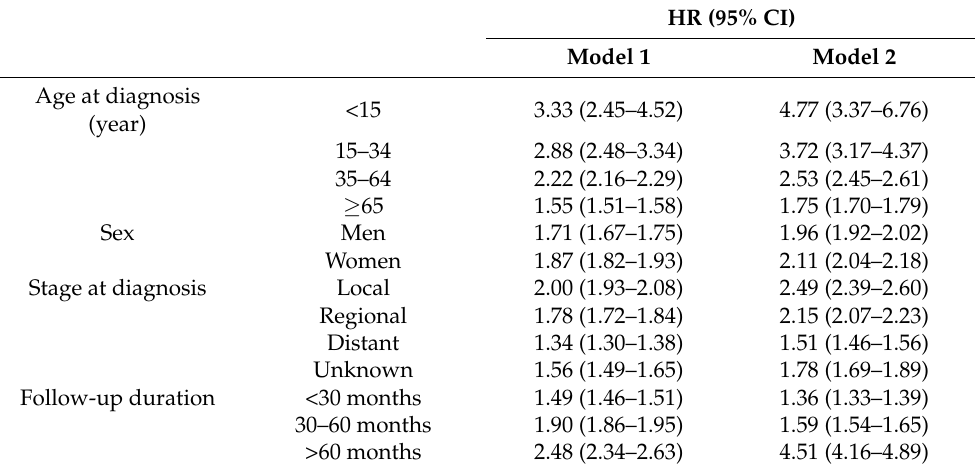
Table 3. HRs for all-cause mortality with an increase of 1 standard deviation in PM 10 exposure, stratified by age, stage at diagnosis and